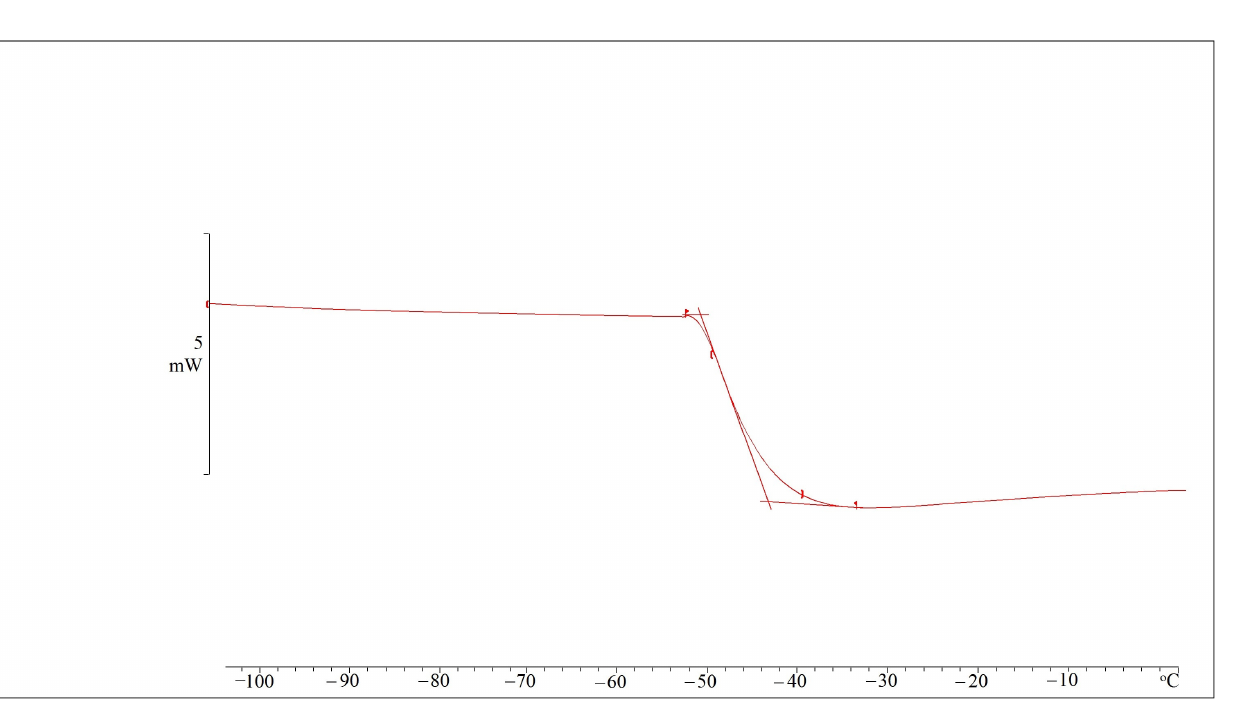
Table 5. Influence of plasticizers on the glass-transition temperature of PVC.